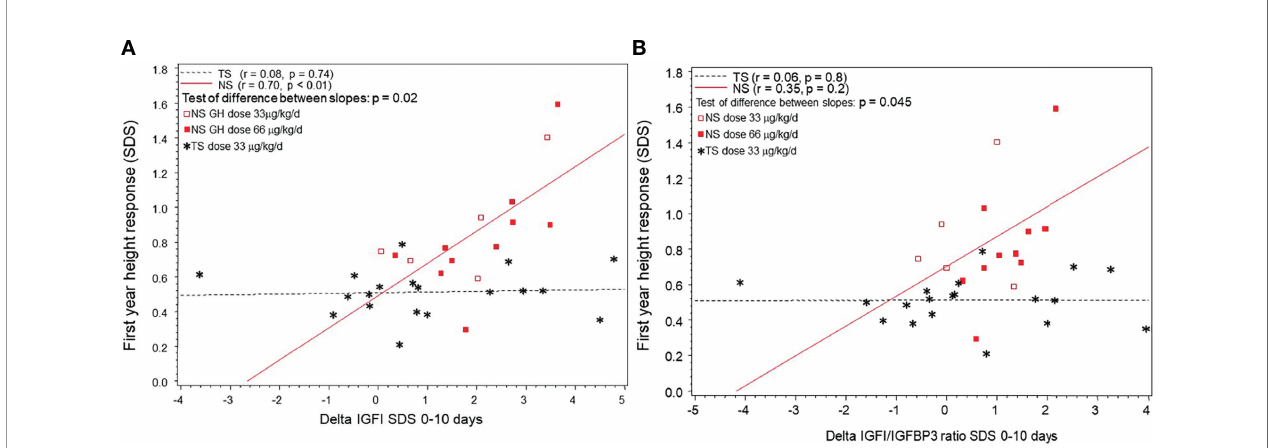
FIGURE 4 | (A) The individual growth response as the fi rst-year delta height SDS correlated to short-term delta IGFI SDS 0-10 days of rhGH in children diagnosed with Noonan syndrome (NS) or Turner syndrome (TS). NS are depicted with circles and TS with stars (in TS shown only for standard dose). (B) The individual growth response as the fi rst-year delta height SDS correlated to delta IGF1/IGFBP3 ratio SDS 0-10 days of rhGH in children diagnosed with Noonan syndrome (NS) or Turner syndrome (TS). NS are depicted with circles and TS with stars (in TS shown only for standard dose).